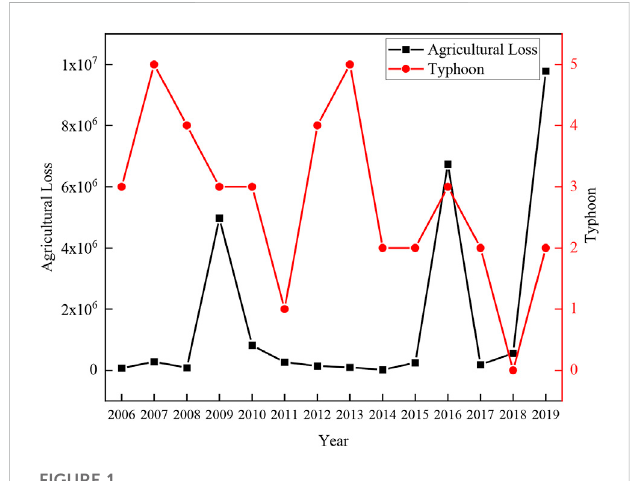
FIGURE 1 Agricultural losses and frequency of typhoons in Taiwan.